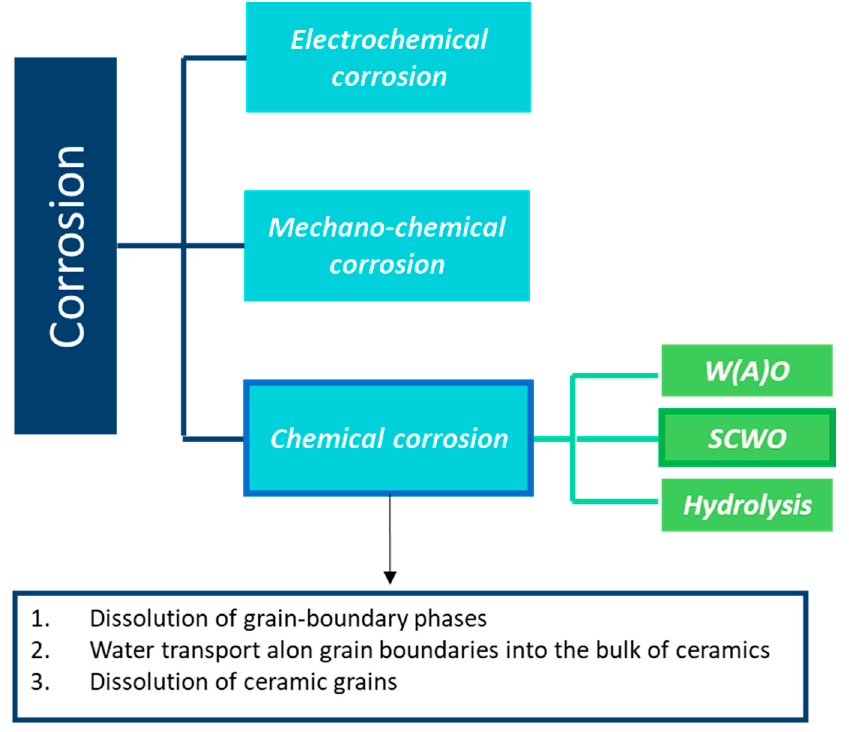
Figure 23. Ordering of the corrosion behavior of ceramic oxide materials. W(A)O stands for wet (air) oxidation and SCWO for supercritical water oxidation.